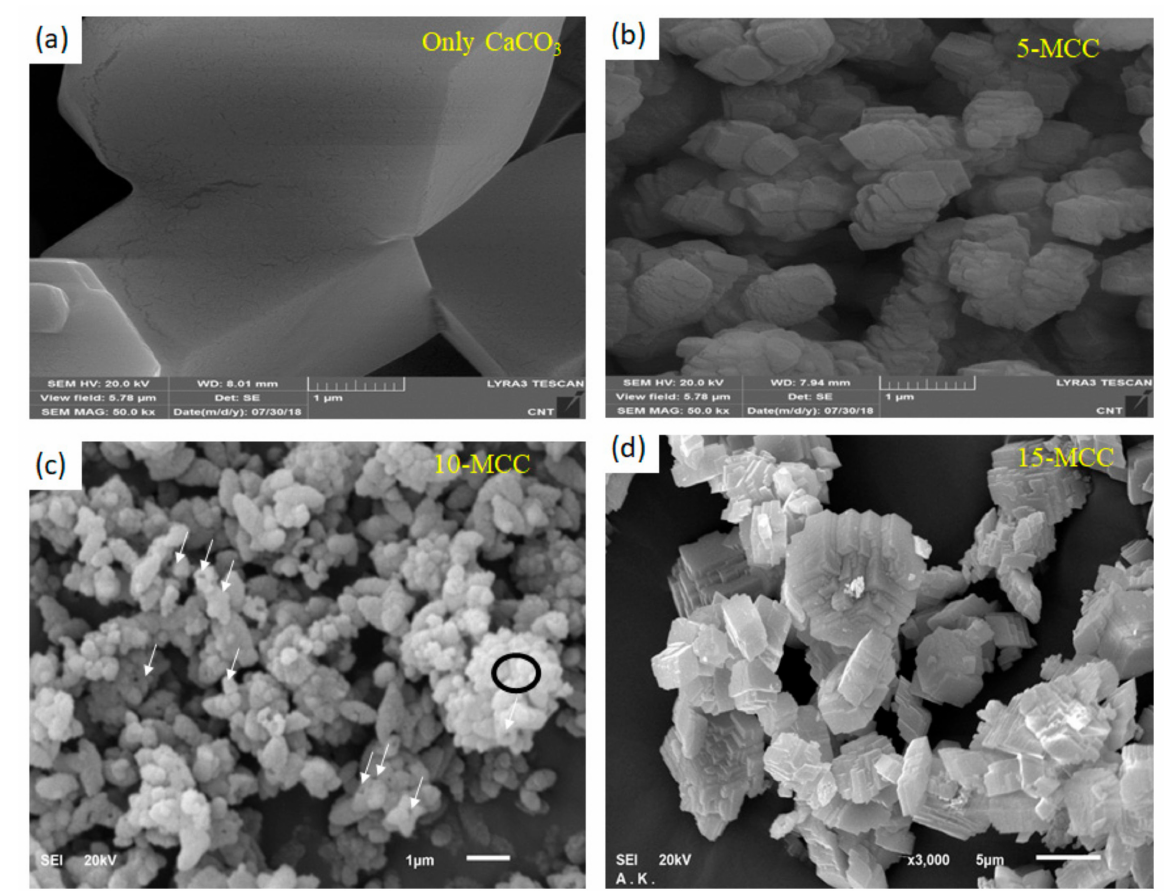
Figure 3. FE-SEM images of the as-synthesized ( a ) CaCO 3 , ( b ) 5-MCC, ( c ) 10-MCC, and ( d ) 15-MCC.